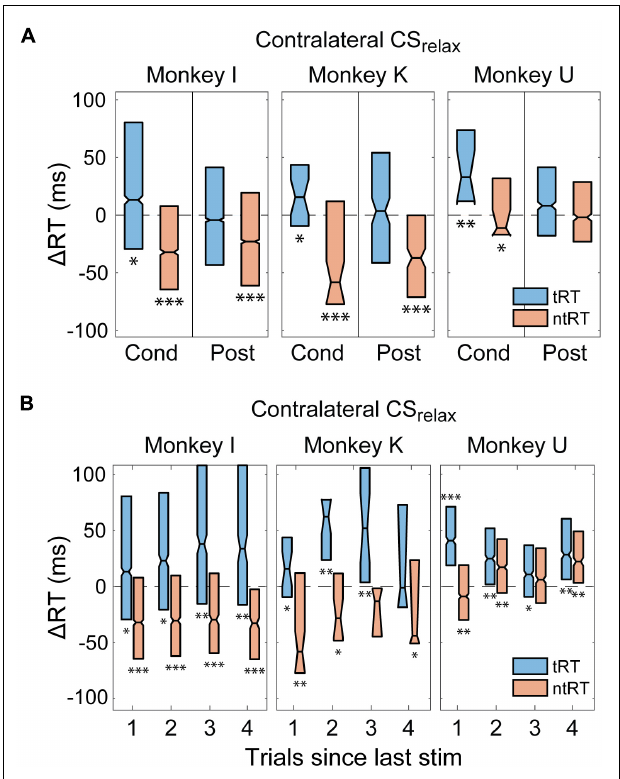
FIGURE 6 | Persistence of changes in RT. (A) RT changes of trials ipsilateral to the stimulated hemisphere stayed faster during Post epoch of CS relax experiments in Monkeys I and K. Increases in CRT did not persist ( ∗ p < 0.01; ∗∗ p < 0.001; ∗∗∗ p < 0.001). (B) Effects of CS were persistent in trials arriving long after CS was delivered during experiments with consistently timed CS. ( ∗ p < 0.01; ∗∗ p < 0.001; ∗∗∗ p <